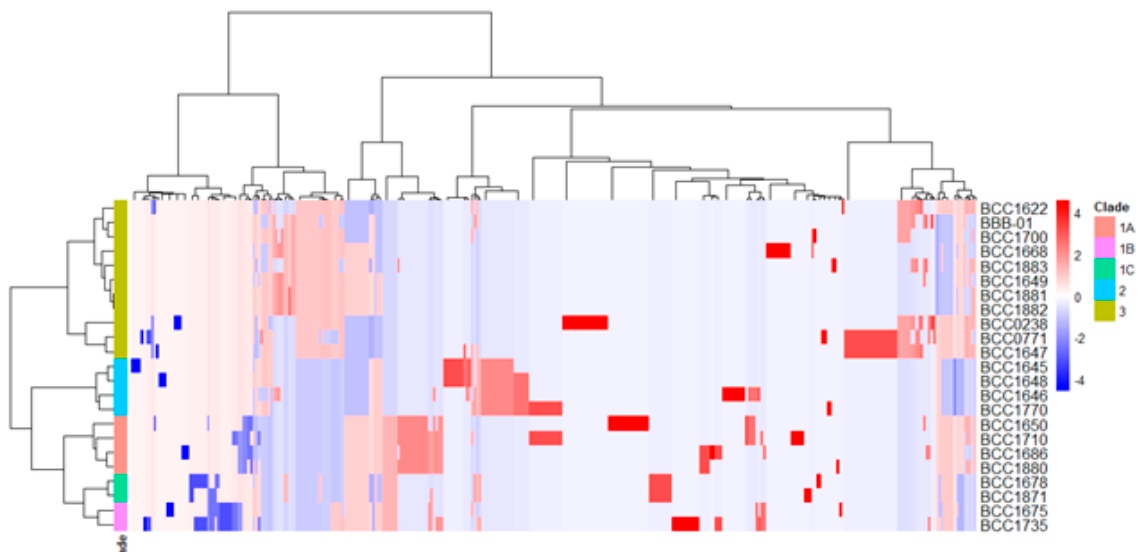
Figure 4. Heatmap clustering for the distribution of genes involved in secondary metabolite biosynthesis in Burkholderia gladioli strains. The 458 genes, which are involved in secondary metabolite biosynthesis (COG category Q) in the pangenome of 23 B. gladioli strains, were analyzed by heatmap clustering using the integrated tool (pheatmap) in the R program. The number of each gene among the 23 B. gladioli strains was normalized, followed by construction of distance matrix using the Manhattan method and hierarchical clustering using the Ward’s minimum variance (ward.D) method. The clade classification based on core genes is shown vertically, while the clustering of the 458 genes is shown horizontally.